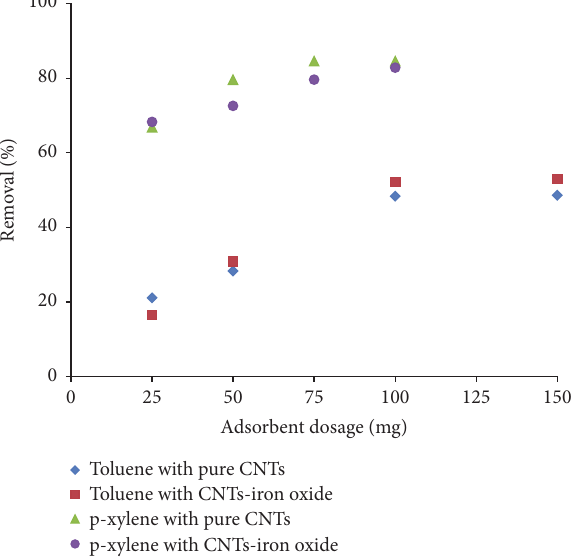
Figure 8: Effect of the adsorbent amount on removal of toluene andp-xylene(initialconcentration:61 mg/Lfortolueneand48 mg/L for p-xylene, contact time: 2hr, shaking speed: 200 rpm, pH: 6, and temperature: 298